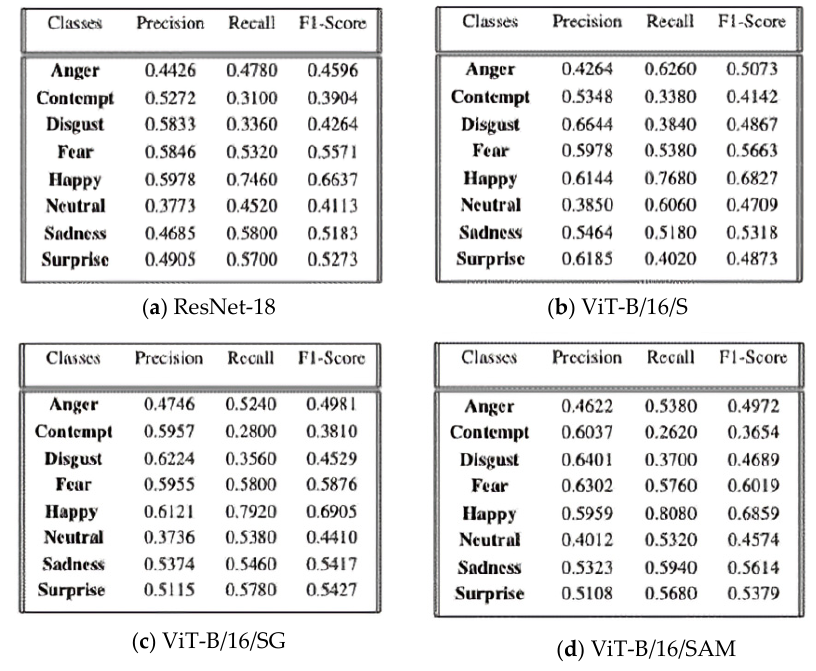
Figure 11. Training and validation loss for ResNet-18 vs. ViT-B/16 models.